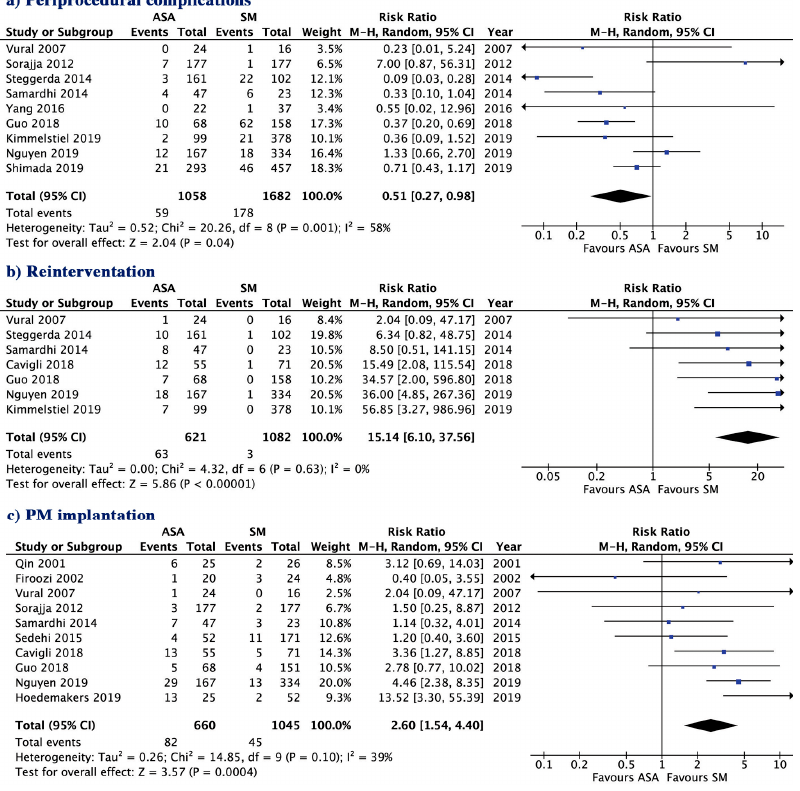
Figure 2. Risk ratio of outcome with septal ablation versus surgical myectomy, ( a ) cardiovascular mortality; ( b ) sudden cardiac death (SCD). ASA, alcohol septal ablation; SM, surgical myectomy; CI, confidence interval. ( c ) Stroke.